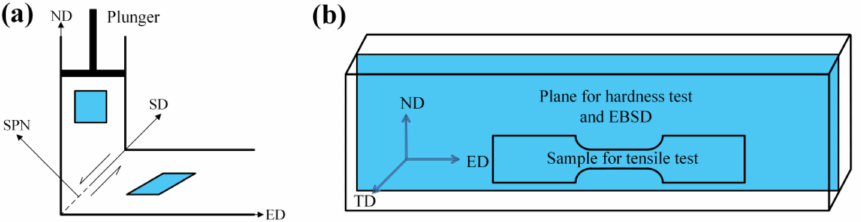
Figure 1. ( a ) Sketch of the ECAP die, showing the shear direction (SD), shear plane normal (SPN), and ( b ) EBSD, hardness, and tensile test measurement planes (ED-ND) with reference to the ECAP die